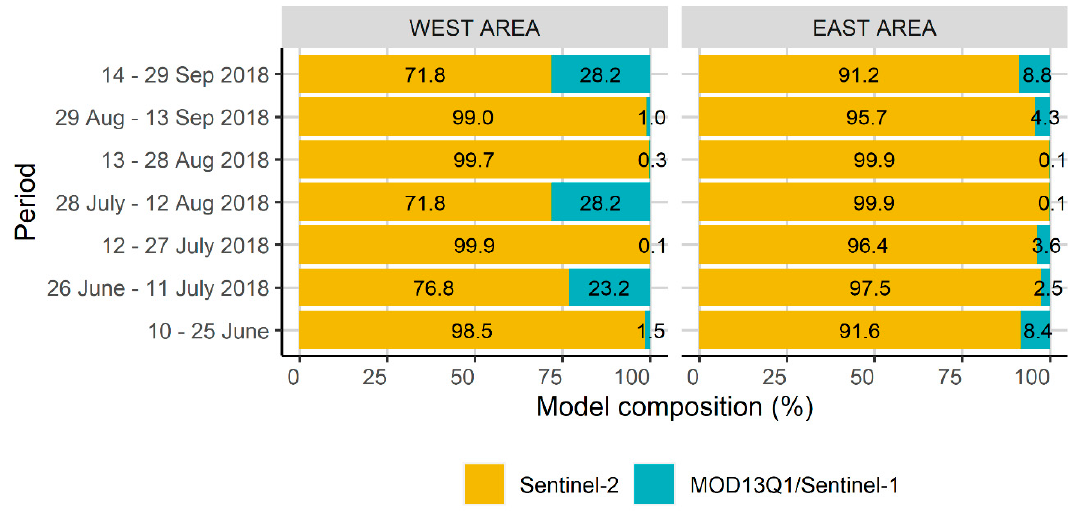
Figure 9. Pixel-based model compositions of temporal rice growth stages map of Sentinel-2 / MOD13Q1 / Sentinel-1 on final paddy condition map on 10 June–30 September 2018.